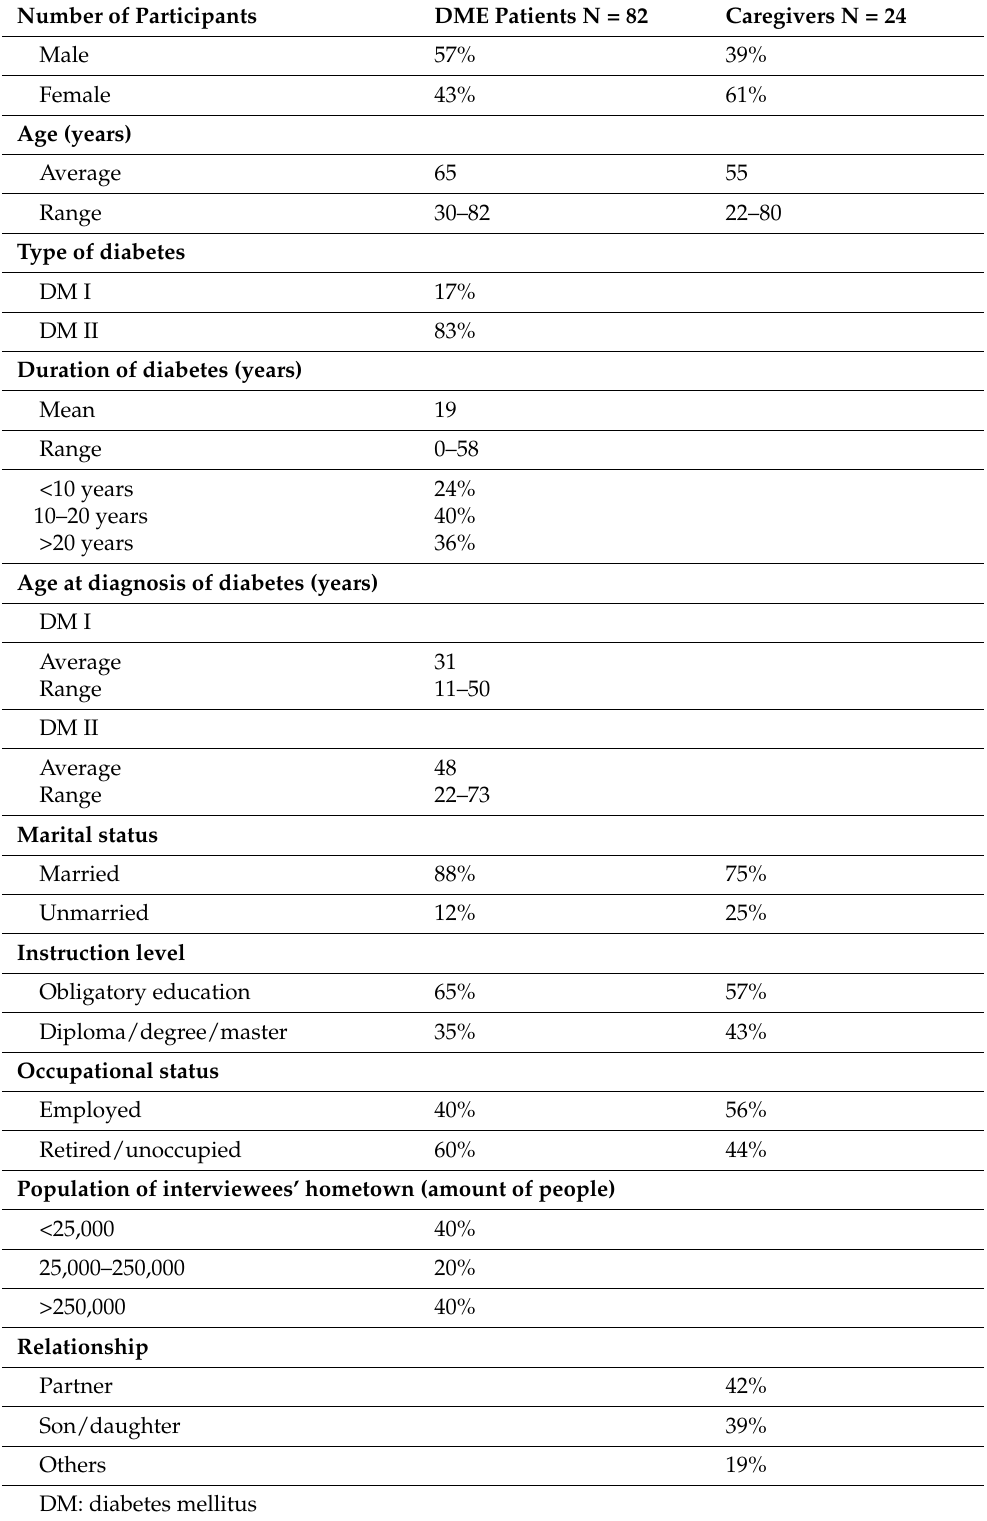
Table 1. Participants’ demographic and clinical